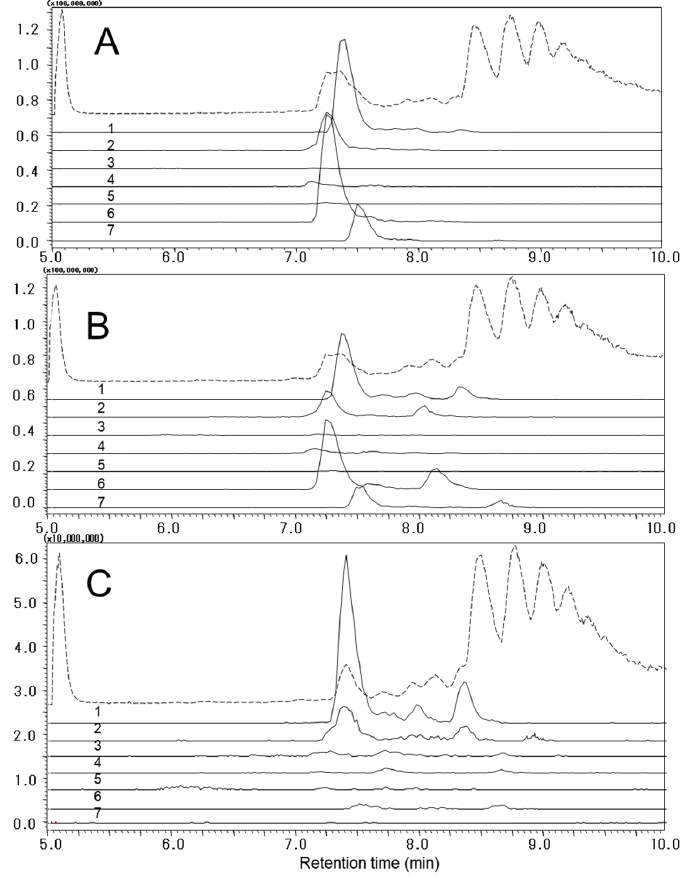
Figure 4. LC-MS chromatograms of B 12 compounds from fermented poultry manure fertilizer A, B, and C products. Panels ( A ) (fertilizer A product), ( B ) (fertilizer B product), and ( C ) (fertilizer C product) show total ion chromatograms (-----) and selected ion monitoring chromatograms ( — ) of ( 1 ) B 12 ( m / z 678.2914), ( 2 ) PseudoB 12 ( m / z 672.7749), ( 3 ) BIA ( m / z 664.2748), ( 4 ) Factor III ( m / z 672.2715), ( 5 ) p -cresolyl dicyanocobamide ( m / z 659.2783), ( 6 ) Factor A ( m /